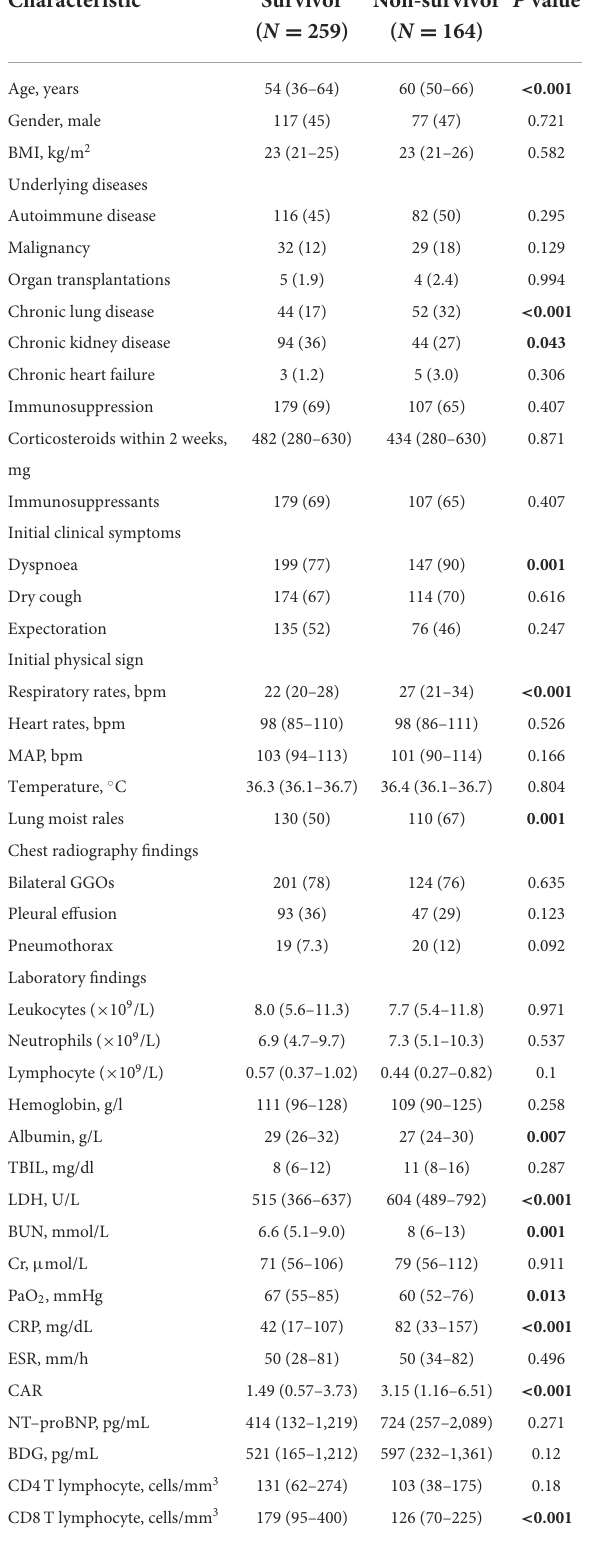
TABLE 2 Clinical features of death PCP cases in the development set.